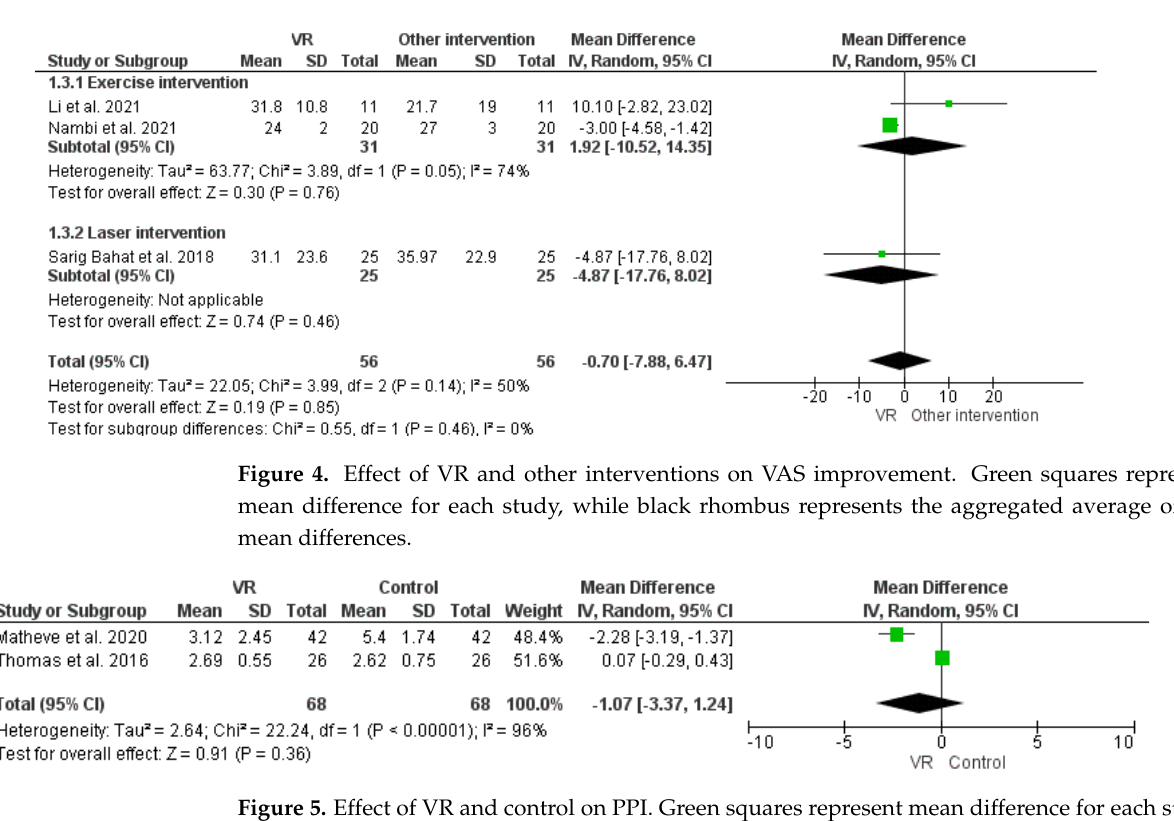
Figure 3. Effects of VR therapy and control on VAS score. Green squares represent mean difference for each study, while black rhombus represents the aggregated average of the mean differences.